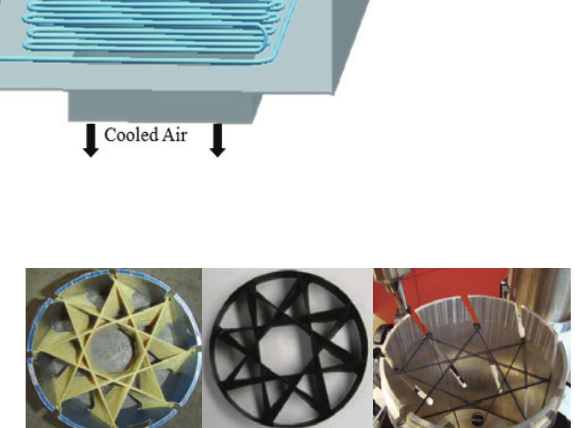
Fig.3. Different patterns of wound impellers